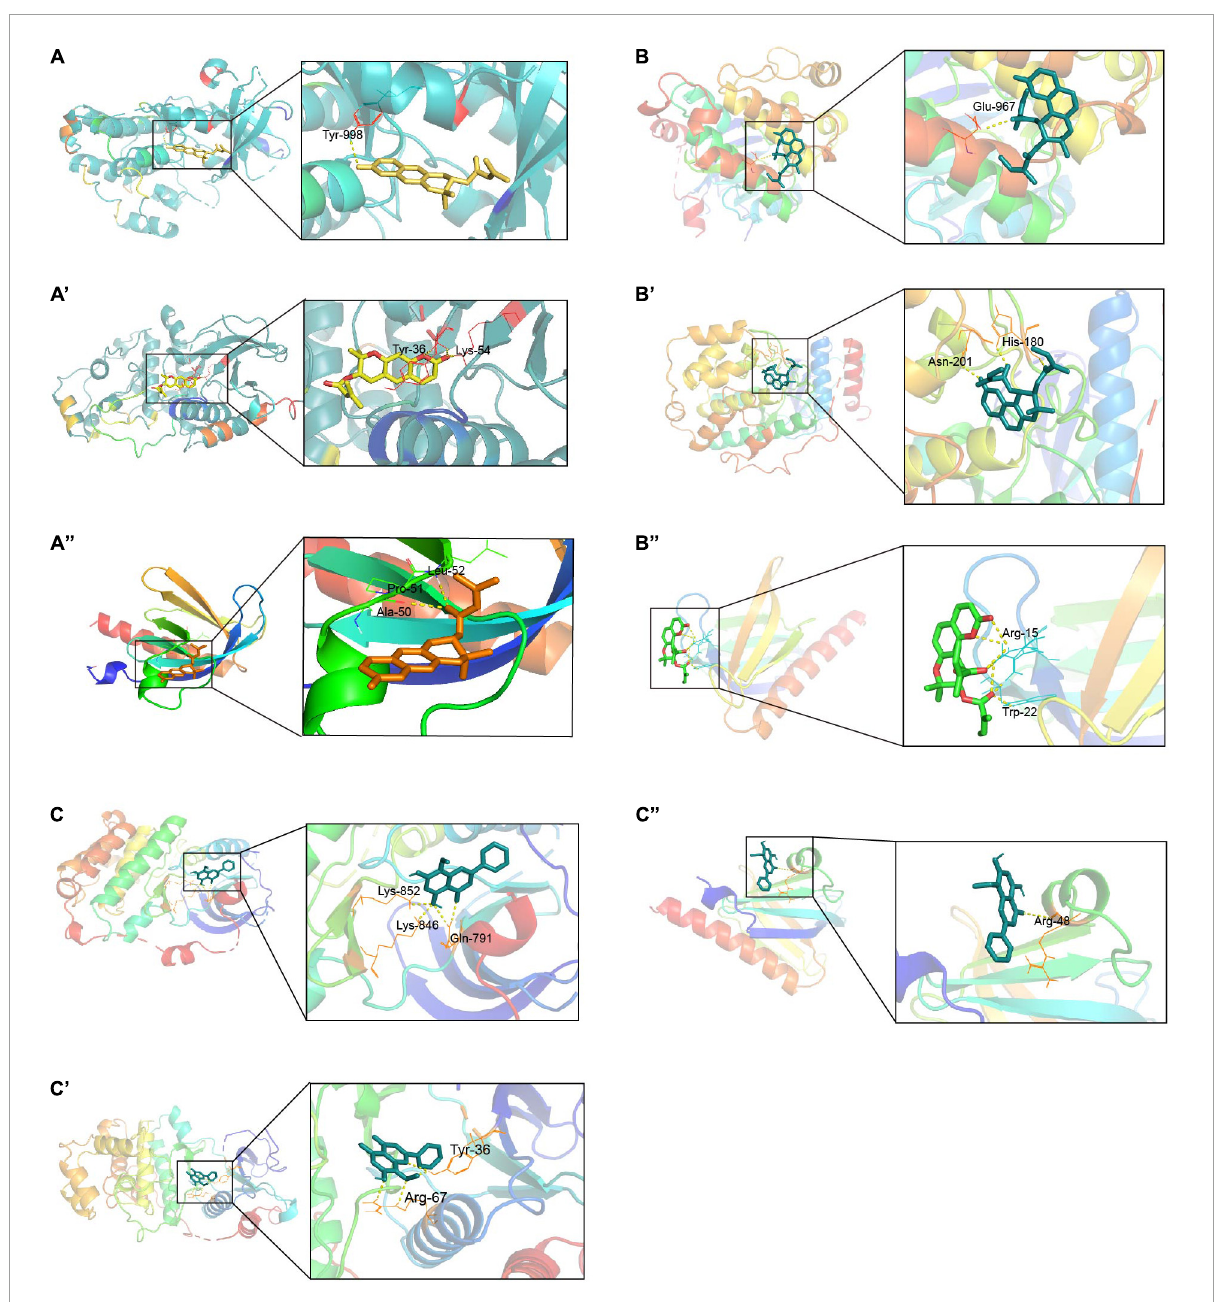
FIGURE8 Docking sites of YPFS ingredients with target proteins. (A) Docking sites of EGFR and decursin. (A’) Docking sites of MAPK1 and decursin. (A”) Docking sites of AKT1 and decursin. (B) Docking sites of EGFR and anomalin. (B’) Docking sites of MAPK1 and anomalin. (B”) Docking sites of AKT1 and anomalin. (C) Docking sites of EGFR and wogonin. (C’) Docking sites of MAPK1 and wogonin. (C”) Docking sites of AKT1 and wogonin. EGFR PDB ID: 1XKK. MAPK1 PDB ID: 1PME. AKT1 PDB ID: